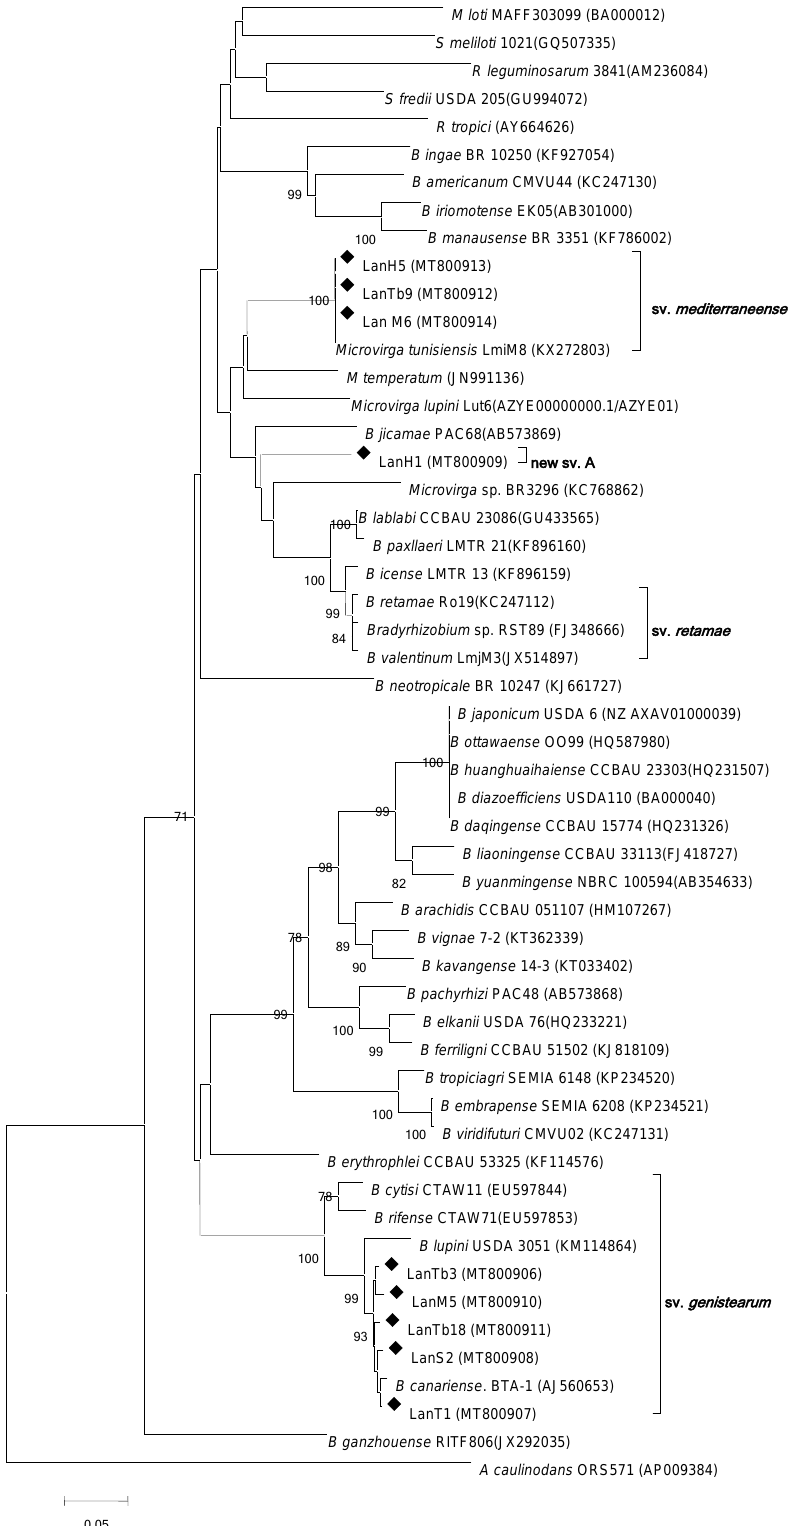
Figure 4. Neighbor-joining phylogenetic tree based on nodC sequences (620 bp) of Tunisian L. angustifolius endosymbionts and reference strains: Tunisian Lan ( (cid:117) ) isolates obtained in this work. Bootstrap values calculated for 1000 replications and those greater than 70% are indicated at the internodes. Accession numbers from GenBank and NCBI databases are shown in brackets. Bar: 0.05 estimated substitutions. M ., Mesorhizobium ; B ., S., Sinorhizobium , Bradyrhizobium , R ., Rhizobium